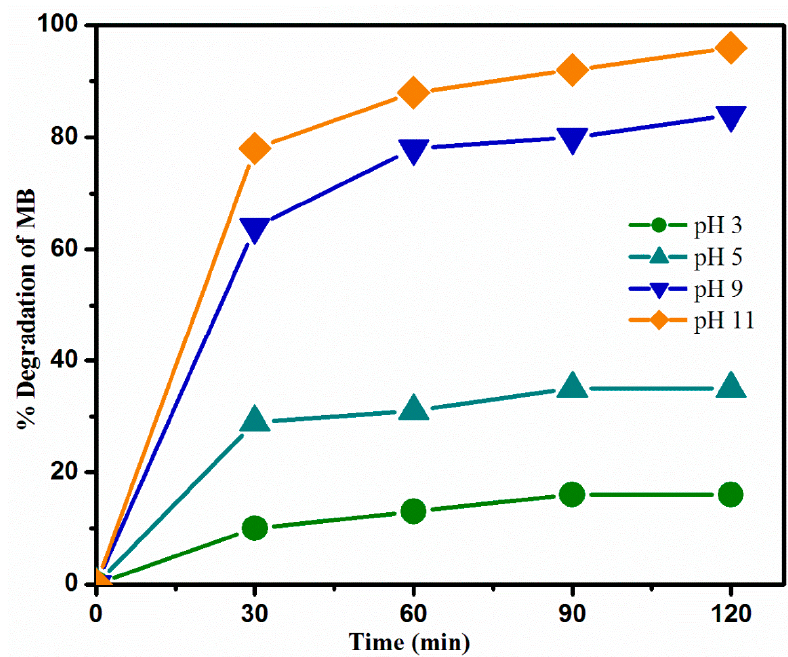
Figure 15. Percentage degradation of MB dye at different pH in varying time intervals using Co 0.1 Al 0.03 Fe 0.17 O 0.4.